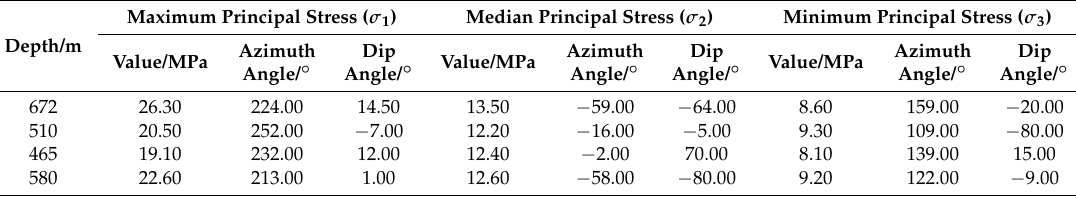
Table 1. Test results of the in-situ stress in Mine E